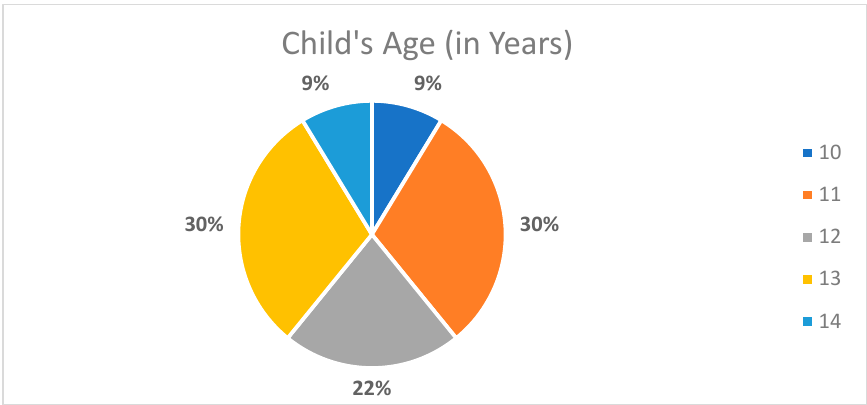
Figure 3. Distribution of the sample of children by age ( n = 23).